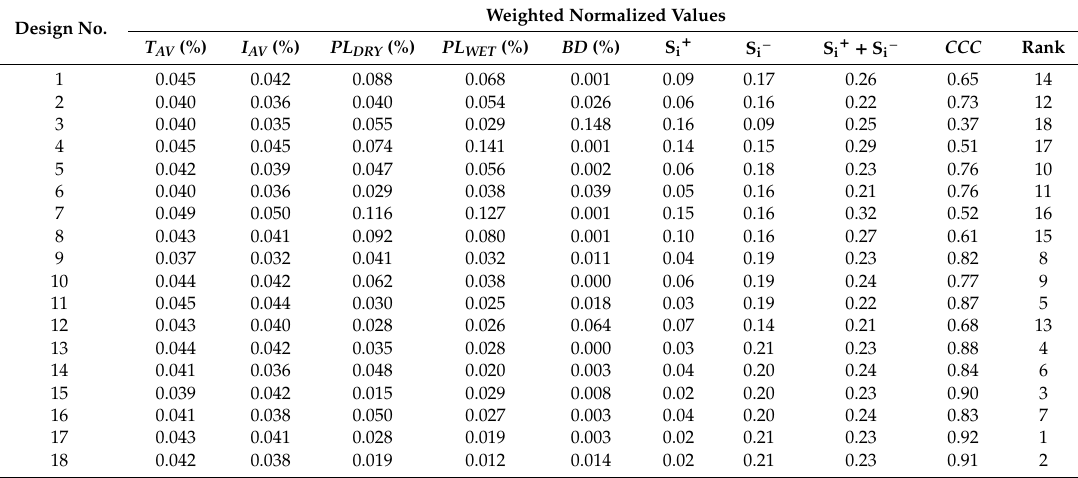
Table 11. Weighted normalized response, CCC values and final ranking.